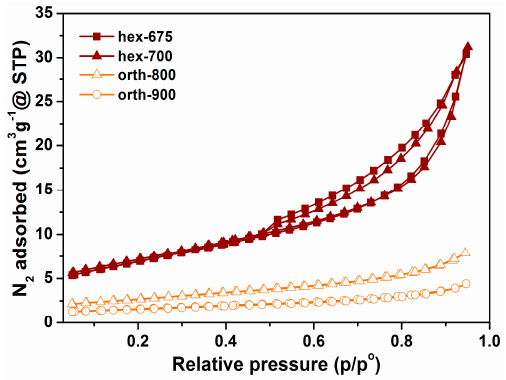
Figure 2. N 2 adsorption isotherms for Brunauer ‐ Emmett ‐ Teller (BET) surface area determination of YFeO 3 calcined at the indicated temperatures.